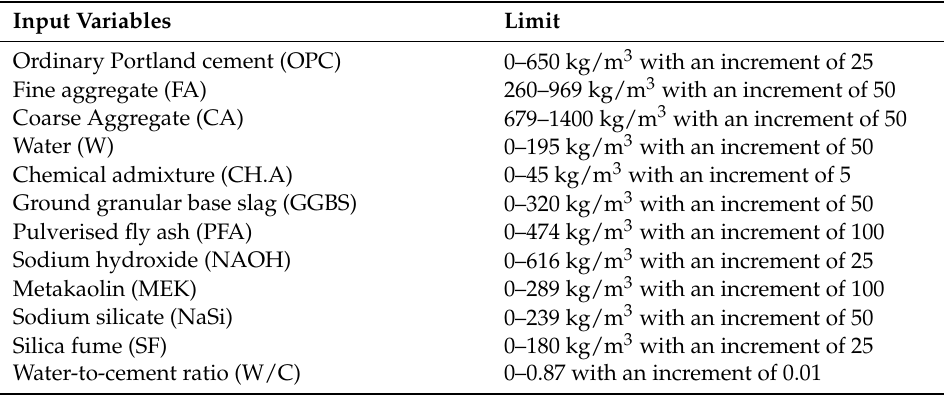
Table 8. Limit of the input variables used.